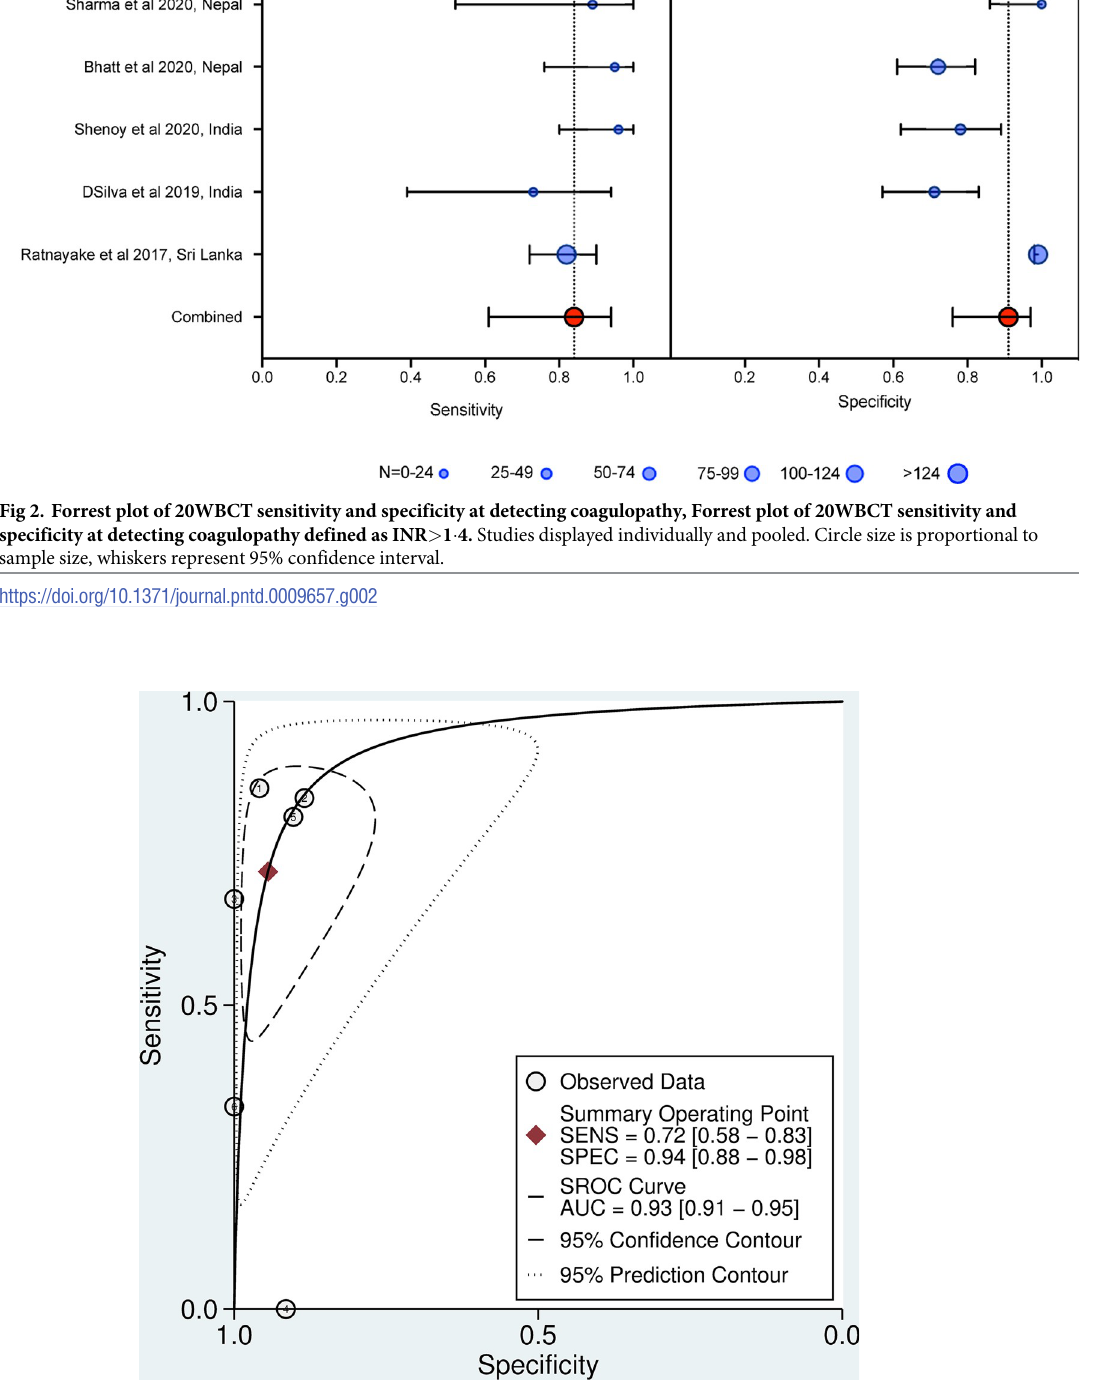
PLOS NeglectedTropical Diseases | https://doi.org/10.1371/journal.pntd.0009657 August 10,